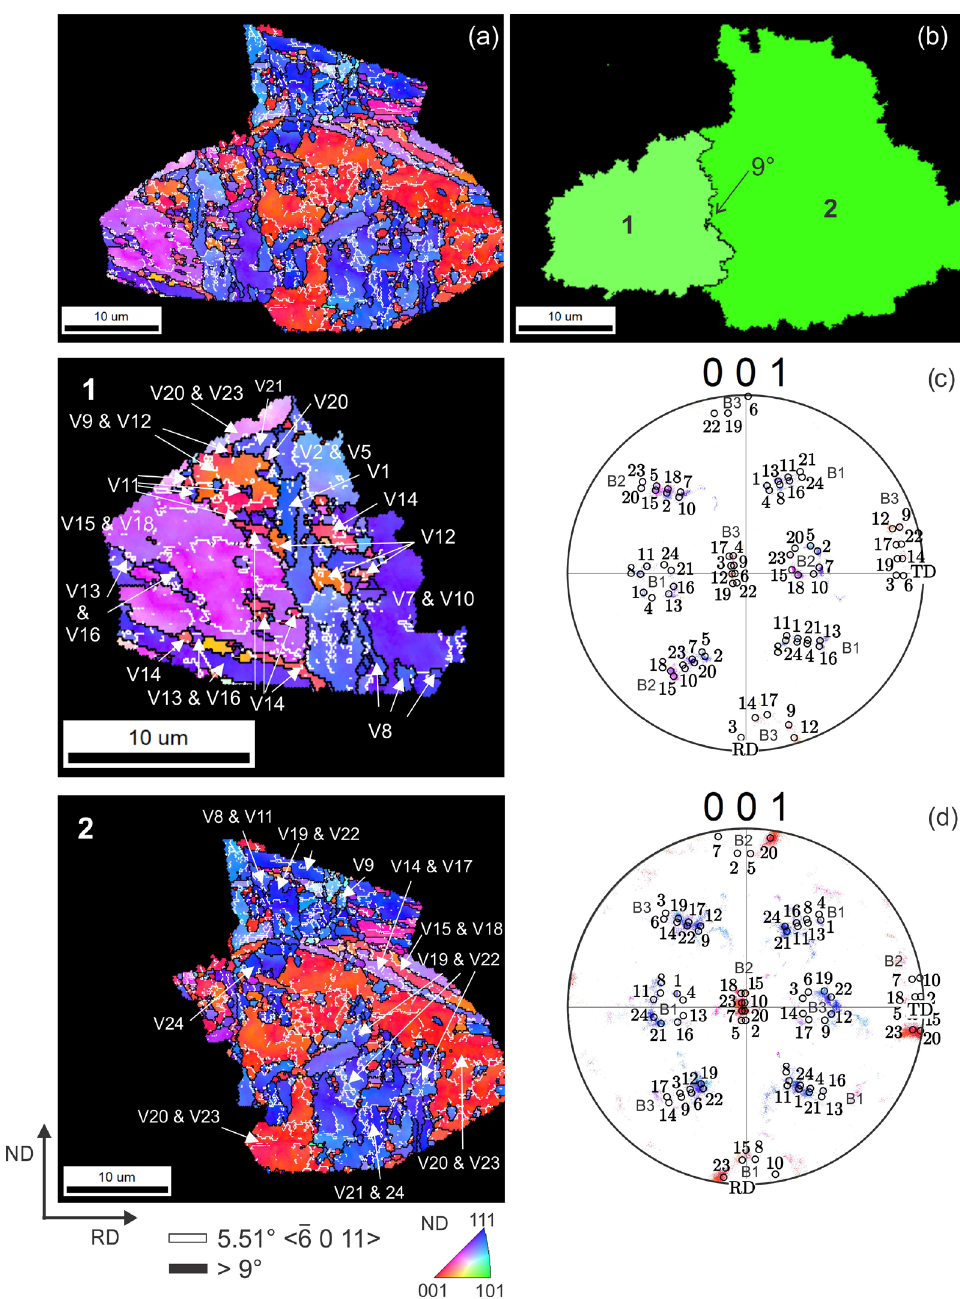
Figure 8. Detailed view of the grain C reconstructed using G-T model, previously displayed in Figure 2 and Figure 3. (a) IPF overlaps the corresponding image quality map of martensite and (b) IPF of Austenite. IPF and {100} pole figures (experimental and calculated): (c) Region 1 and (d) Region 2 of reconstructed austenite